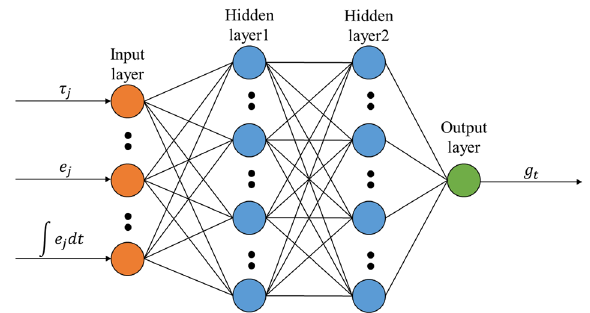
Figure 2. The structure of the actor network.